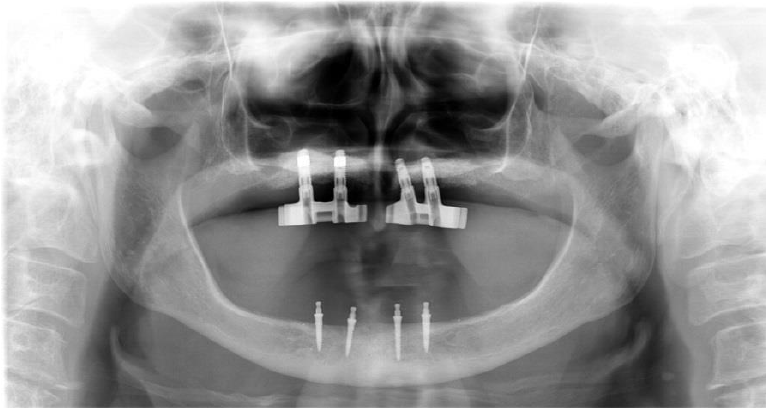
Figure 7. Panoramic image after 2 years of follow up.